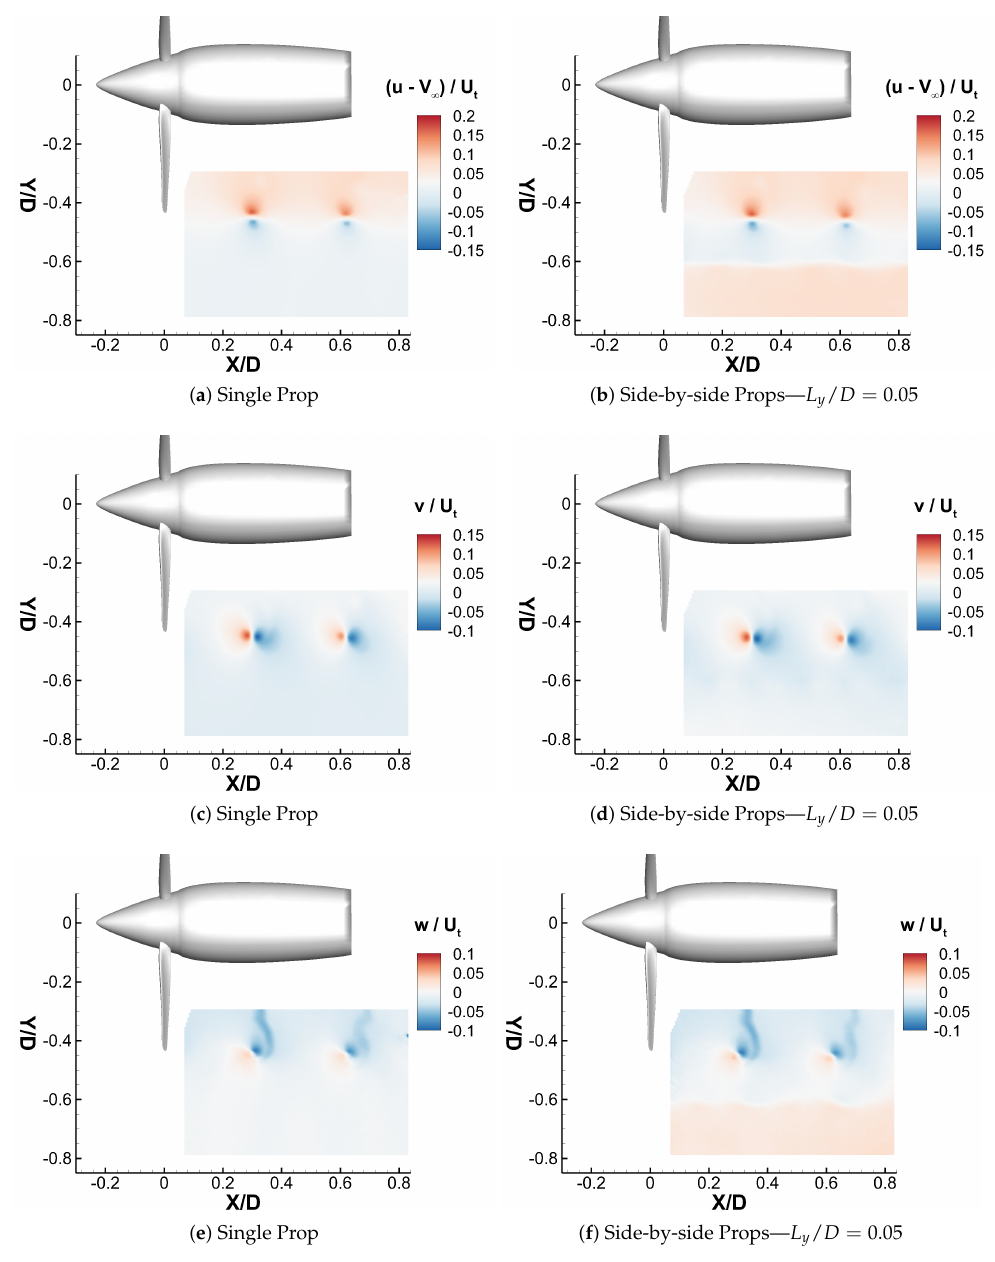
Figure 11. Comparison of the phase-averaged non-dimensional velocity component contours at blade azimuthal angle ψ = 90 ◦ for advance ratio J = 0.8, Re D = 1.96 × 10 6 , and M t = 0.325. For the lower advance ratio test case J = 0.4, the comparison of the freestream compo- nent velocity profiles extracted in the inner wake of the upper propeller at tip vortex core location #A1 shows that the aerodynamic interaction of the nearby propeller produces